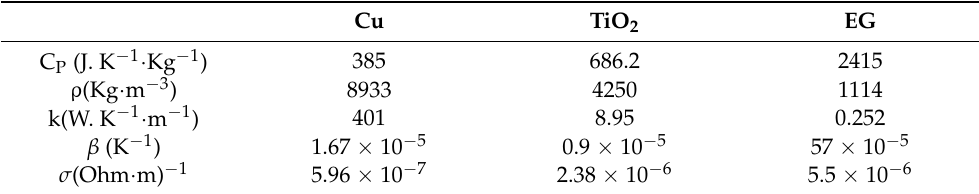
Table 4. Thermo-physical properties of Cu- TiO 2 / EG hybrid nano-fluid. Cu TiO 2